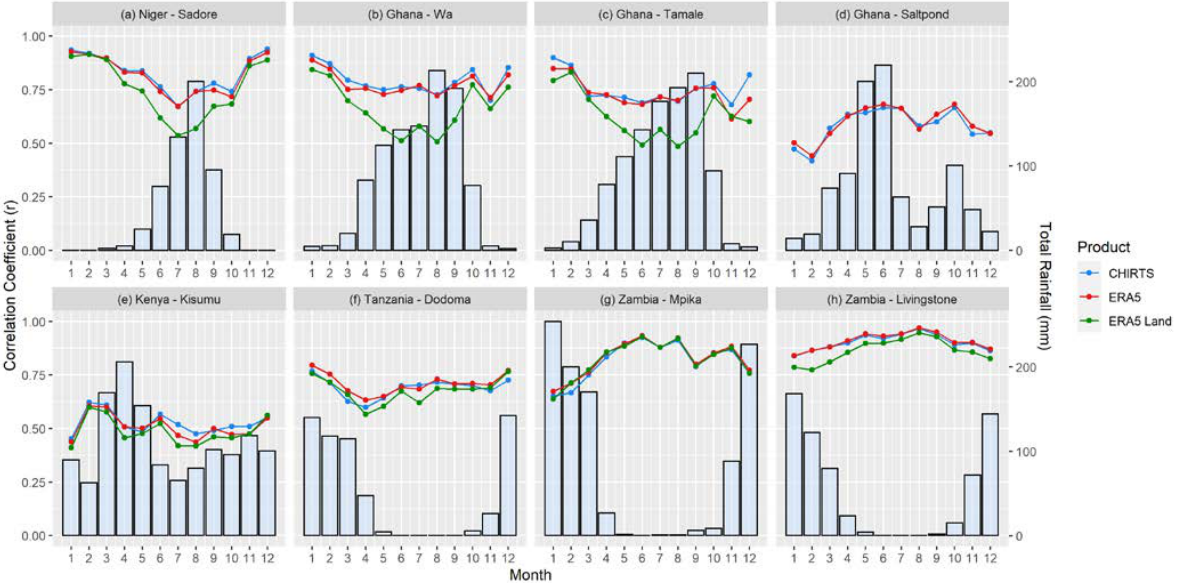
Figure 4. The lines show the correlation of daily maximum temperatures for each month between the station data and CHIRTS (blue), ERA5 (red) and ERA5-Land (green) at the stations in Niger and Ghana ( a – d ) and Kenya, Tanzania and Zambia ( e – h ). The light blue bars show the mean monthly total rainfall calculated from the station